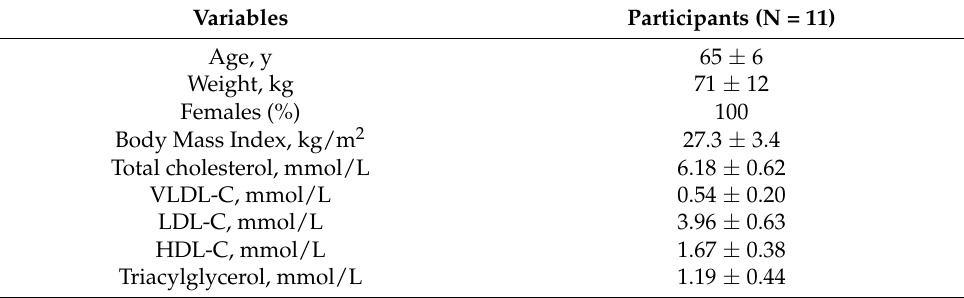
Table 1. Baseline characteristics of the study